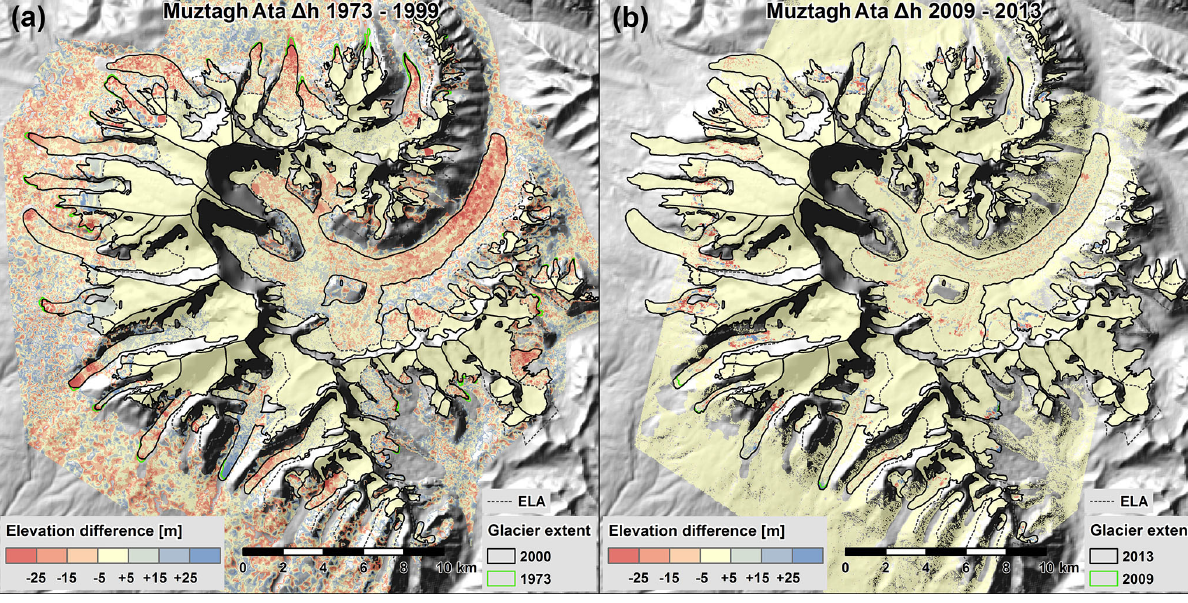
Figure 7. Co-registered map of elevation differences during 1973–1999 (a) and 2009–2013 (b) after outlier and gap-filling processing for glacier mass-balance and vertical uncertainty